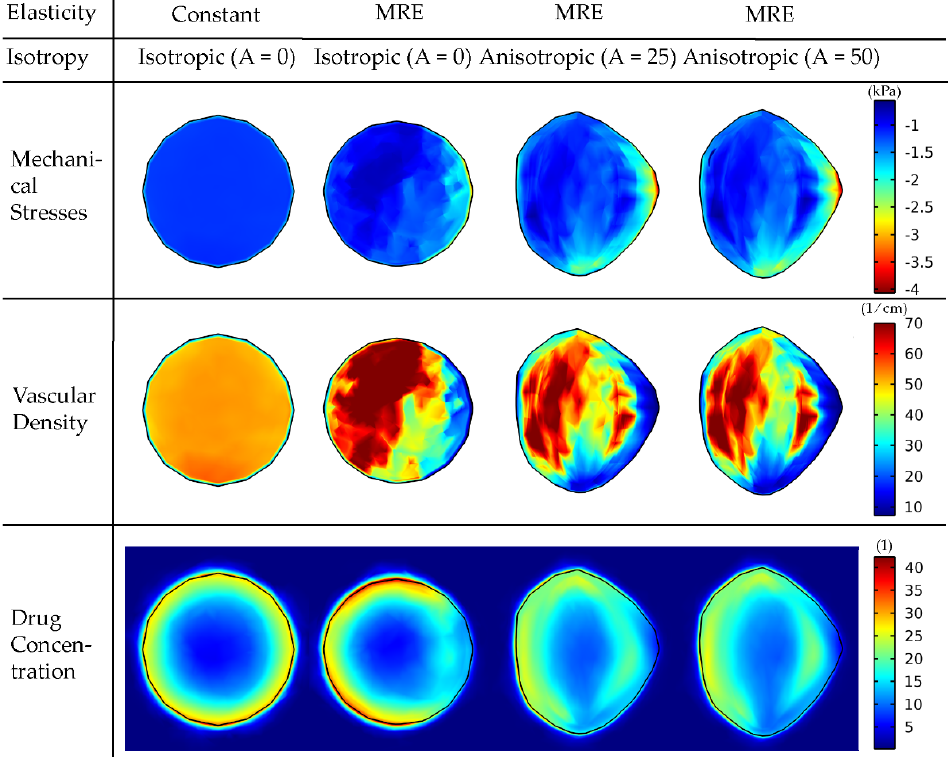
Figure 3. Mechanical stress, vascular density and drug concentration taken up by cancer cells for elastography data of patient 1. A cut plane at the center of the tumor is displayed to visualize the interior of the tumor. Results are presented at day 43 of the simulation. Comparison among isotropic and anisotropic tumor growth by varying the degree of anisotropy (A) is shown. For the constant elasticity case, the average value of the shear modulus was used in the tumor region and the average value of the normal brain for the rest of the brain. A drug of 2 nm in diameter was used to simulate small therapeutic molecules, whereas the tumor vessel wall pore size was set to 200 nm. The bulk mechanical stress is displayed (i.e., the trace of the stress tensor), and the negative sign denotes compression. Table 1. Mean and standard deviation values of the spatial distribution of the vascular density and drug concentration in the tumor for the 4 cases considered in Figure